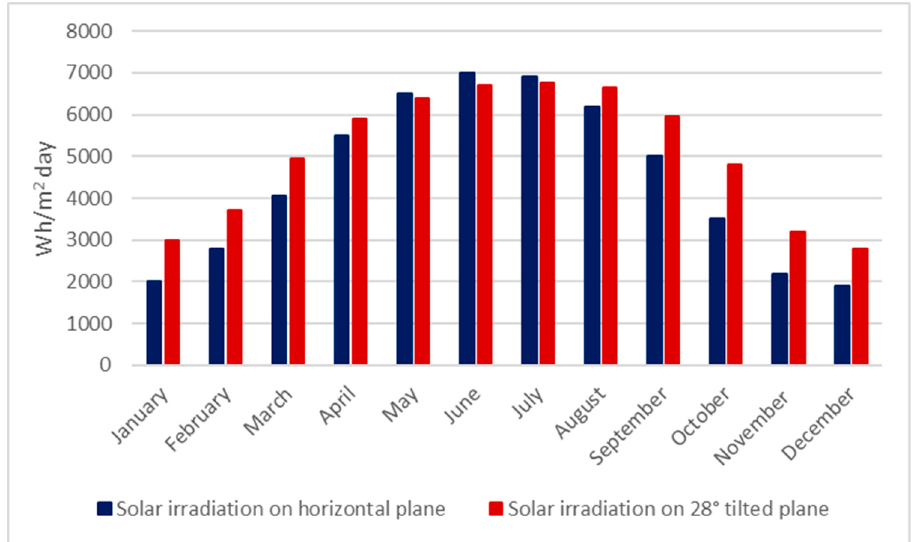
Figure 3. Monthly solar irradiation in Reggio Calabria.